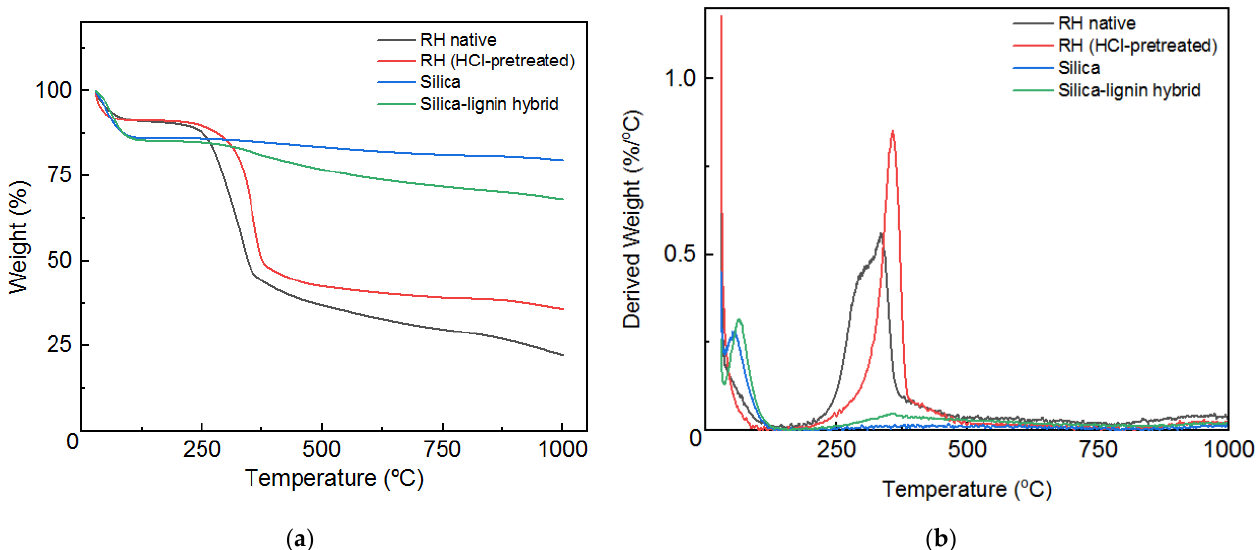
Figure 4. ( a ) Thermogravimetric analysis of RH native, RH (HCl-pretreated), silica, and silica–lignin hybrid and ( b ) DTG analysis of RH native, RH (HCl-pretreated), silica, and silica–lignin hybrid.